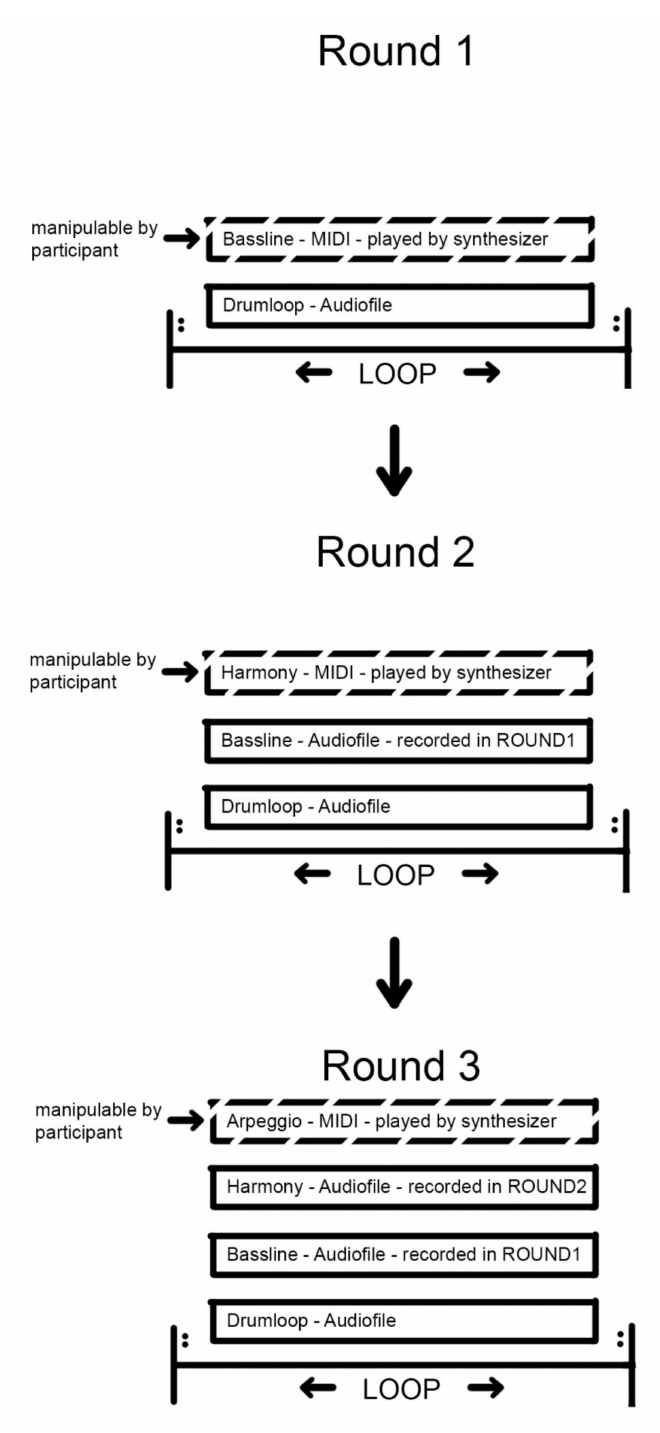
Figure 2. Representation of the process of part one of the experiment. MIDI = Musical Instrument Digital